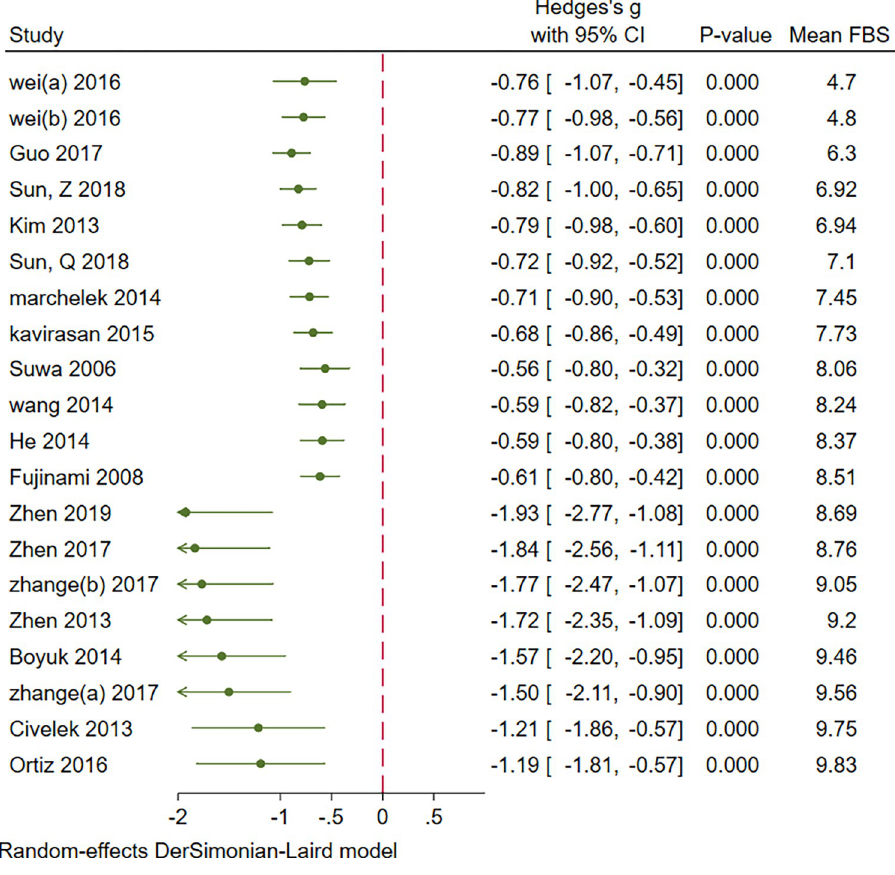
Fig 10. Cumulative meta-analysis of BDNF levels in patients with DM by mean FBS of cases. https://doi.org/10.1371/journal.pone.0268816.g010 PLOS ONE | https://doi.org/10.1371/journal.pone.0268816 February 14,